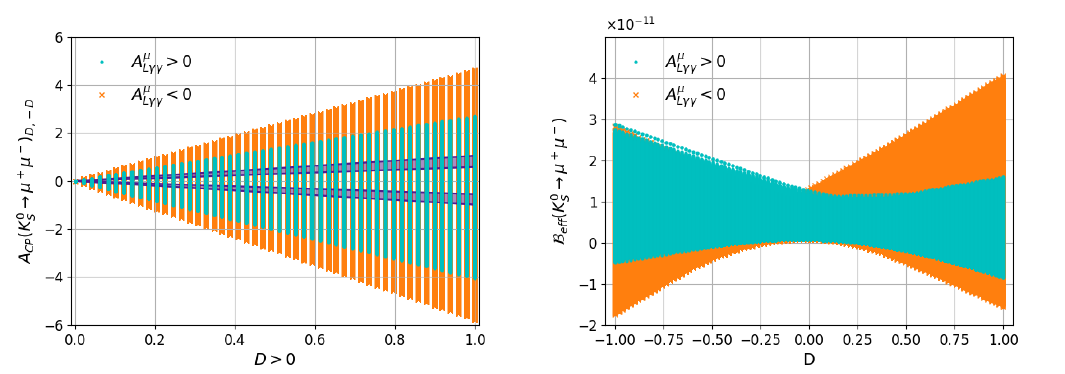
(cid:0) (cid:1) (cid:14) LL 6 = 0 and ( M 3 (cid:1) (cid:22) ) < 0. Plots of A CP ( K 0 d 12